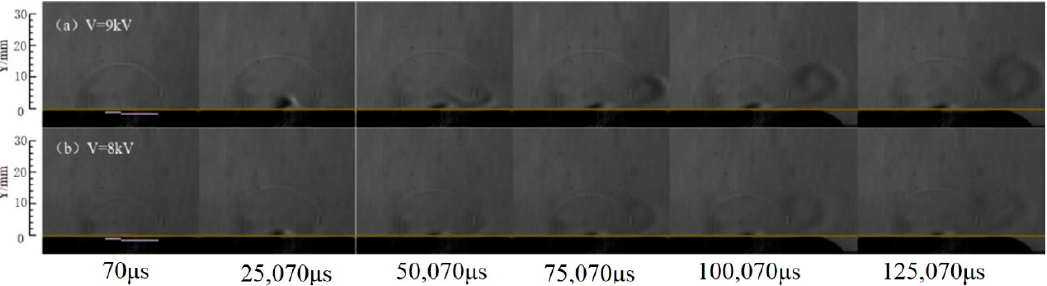
Figure 17. Schlieren images of induced flow field at different voltages.